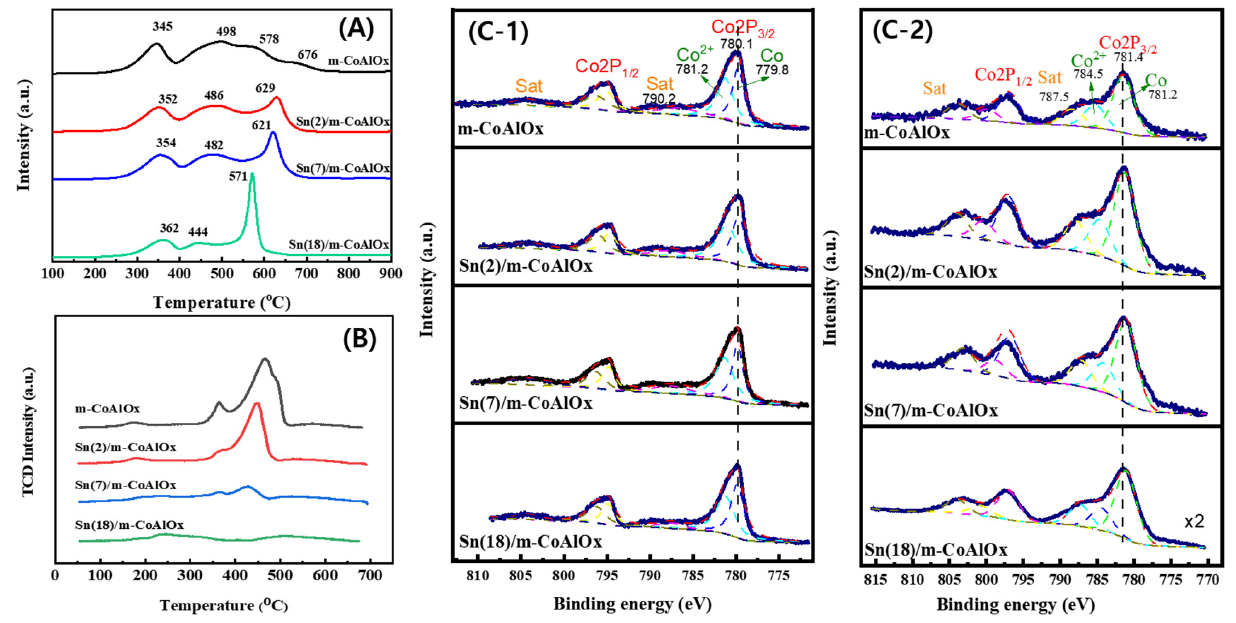
Figure 2. Bulk and surface propeties of the fresh Sn/m-CoAlOx catalysts; ( A ) TPR patterns, ( B ) CO- TPD profiels, and ( C ) XPS spectra of Co 2p 3/2 peak on the ( C-1 ) fresh (reduced) and ( C-2 ) used Sn/m-CoAlOx.